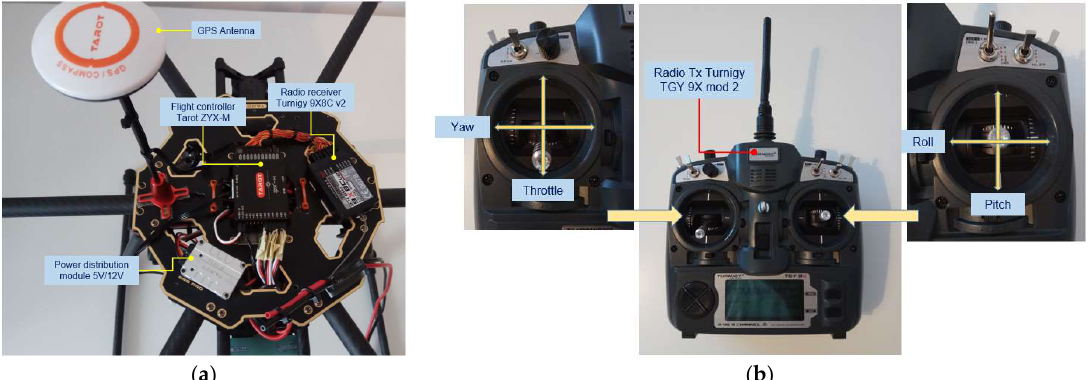
Figure 1. Variant v1 of the hexacopter. ( a ) Equipment; ( b ) Radio